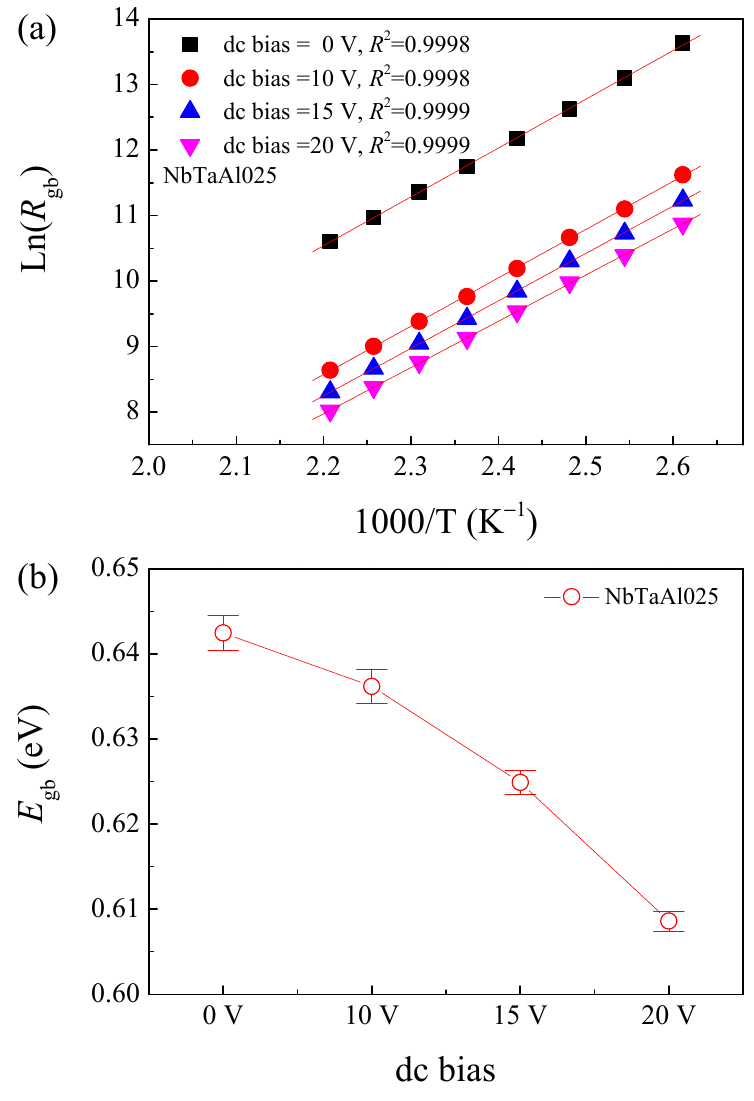
Figure 9. ( a ). Arrhenius plot of R gb for the selected NbTaAl025 sample under the dc bias range of 0–20 V. ( b ) Correlation between dc bias and E gb of this sample.